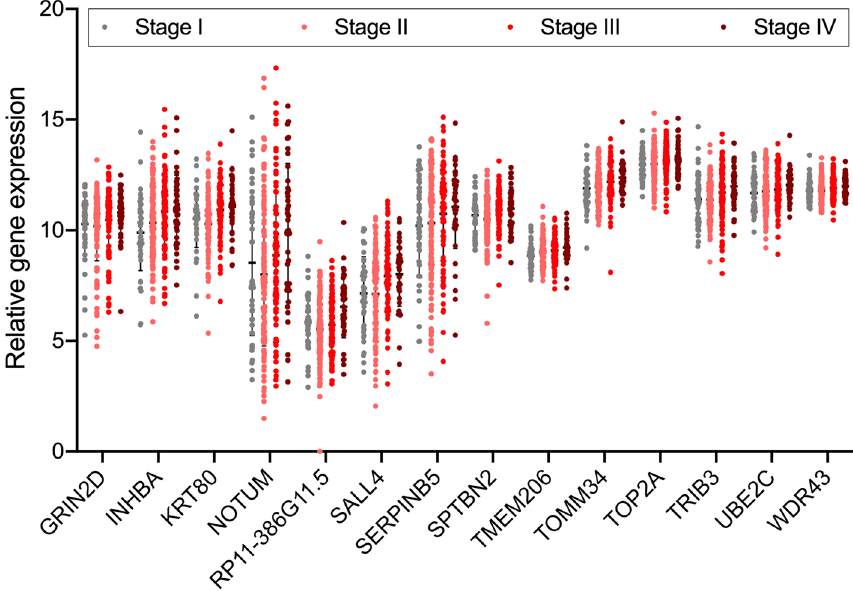
Figure 6. Relative gene expression plot of the 14 stage-positive related DEGs. GraphPad Prism was used to create the scatter plot, and each dot represents a